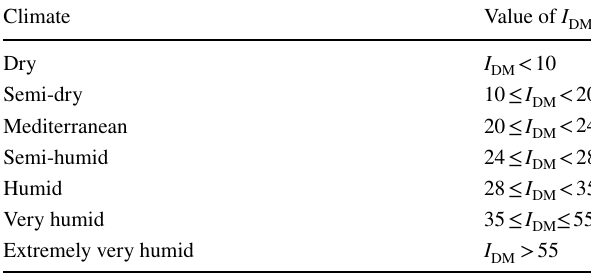
Table 2 De Martonne aridity index classification (Baltas